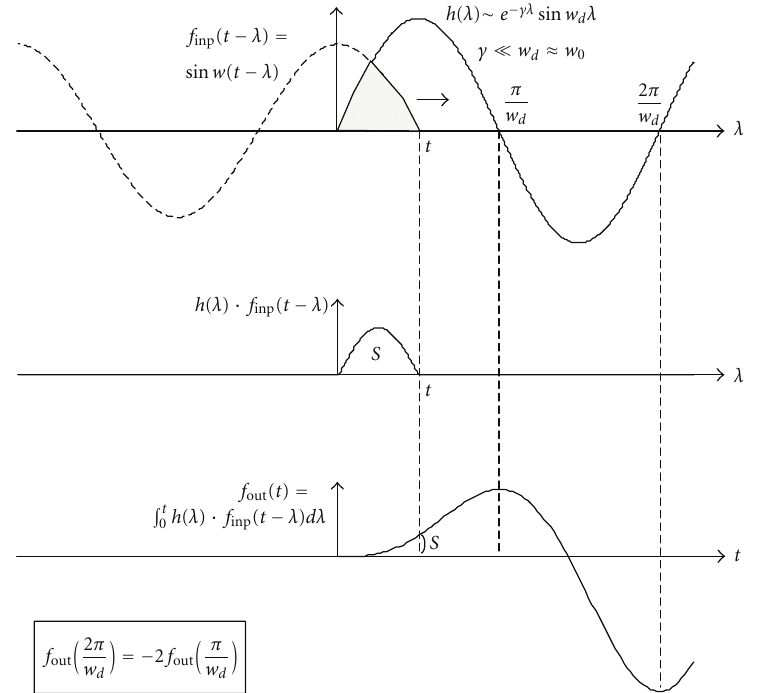
Figure 10: Graphically obtaining the resonant response for a second-order oscillatory system and a sinusoidal input, according to (10). The envelope (not shown) has to pass via the maxima and minima of 𝑓